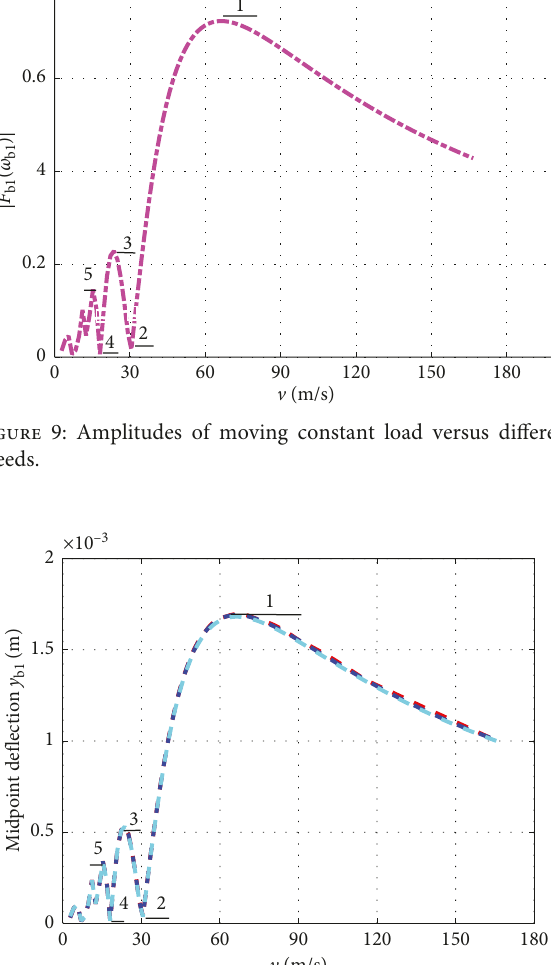
Table 3: Speeds corresponding to the extreme points of | F